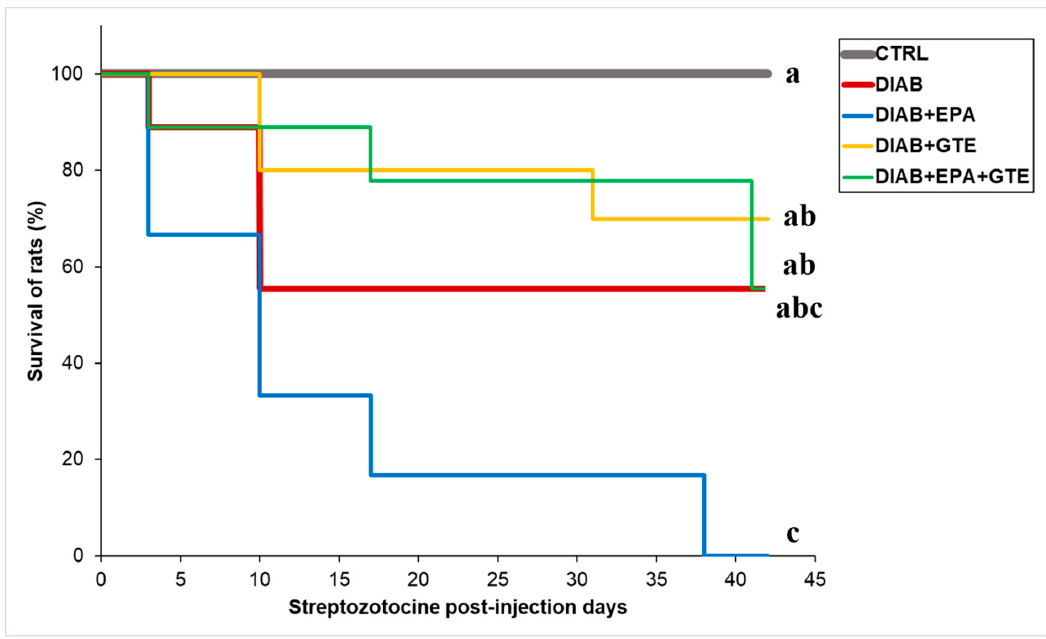
Figure 2. Survival rate of the animals. CTRL: Control group; DIAB: Diabetic rats; GTE: Green tea 303 extract enrichment; and EPA: Eicosapentaenoic acid enrichment. a, b, c: means without a common 304 letter on each line are significantly different, p < 0.05. 305